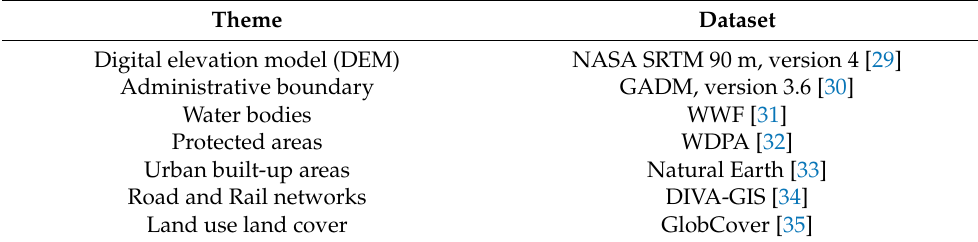
Table 2. Topographical and land cover datasets used to evaluate suitable land